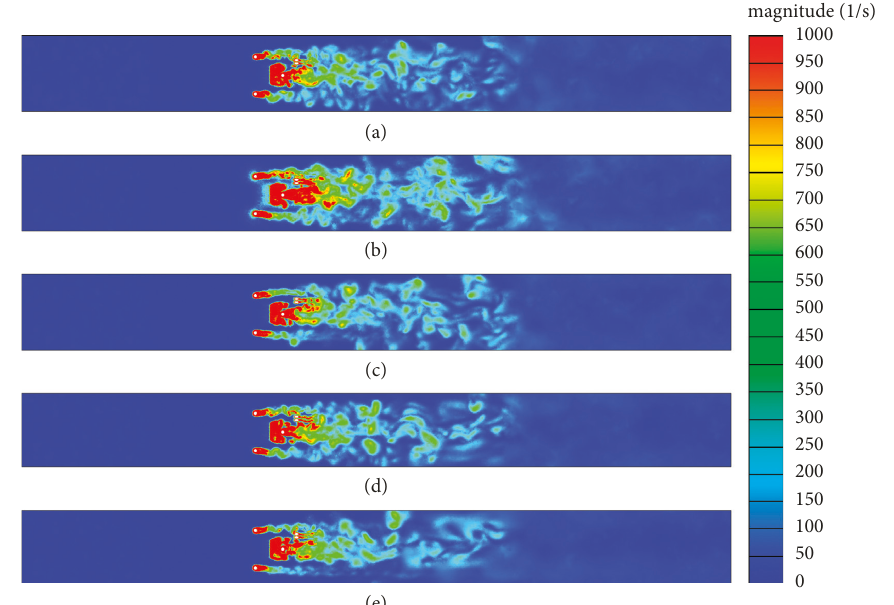
Figure 11: Average vorticity amplitude of pantograph using (a) LES, (b) SAS, (c) IDDES sst-k ω , (d) DDES sst-k ω , and (e) DDES R-k ε